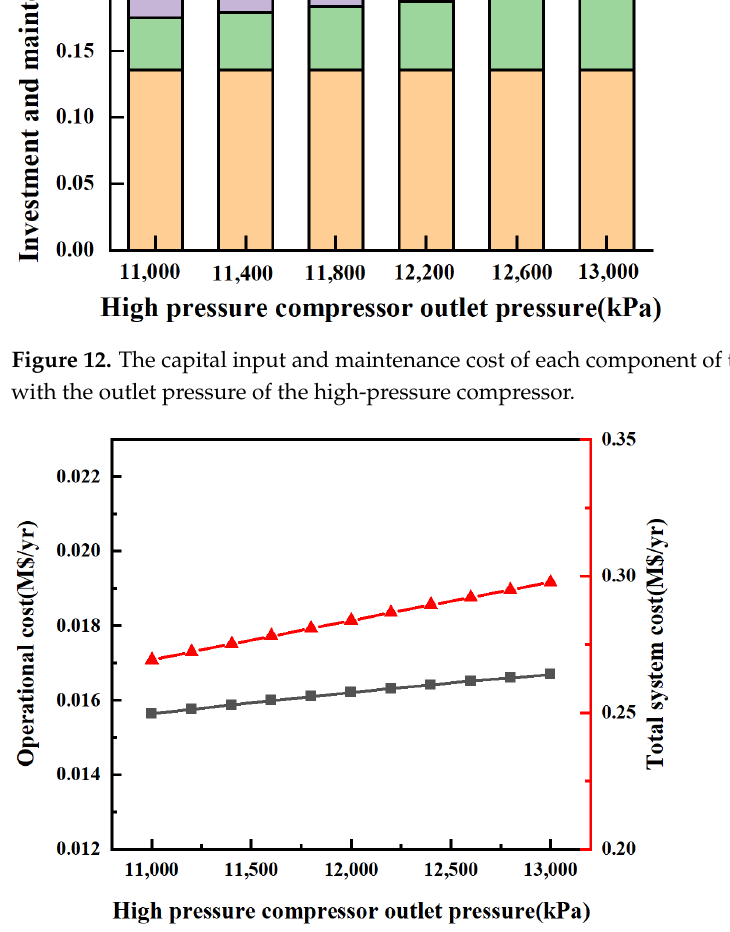
Figure 13. The operating costs and total costs of each component of the coupling system varied with the outlet pressure of the high-pressure compressor. Table 7. The capital investment and maintenance costs of the components at different high pressure compressor outlet pressures.